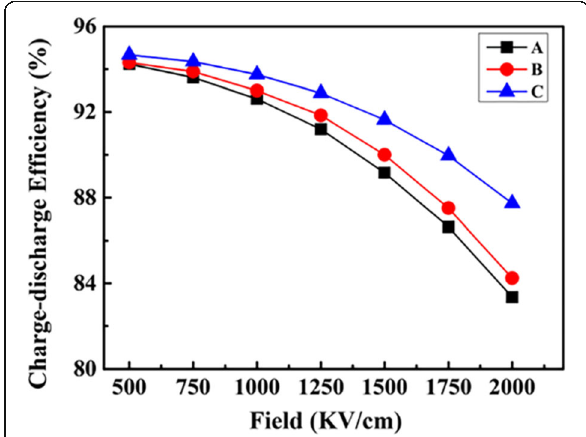
Fig. 2 The charge-discharge efficiency of different molecular weight ArPTU films (A, B, and C are polythioureas synthesized by the molar ratio PDTC/MDA (1/1), PDTC/MDA (0.95 /1), and PDTC/MDA (1.05/1))